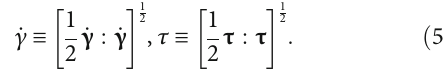
= 0 : 2 and Re = 20 . (a) Bn = 0 . (b) Bn = 10 . (c) Bn = 50 p